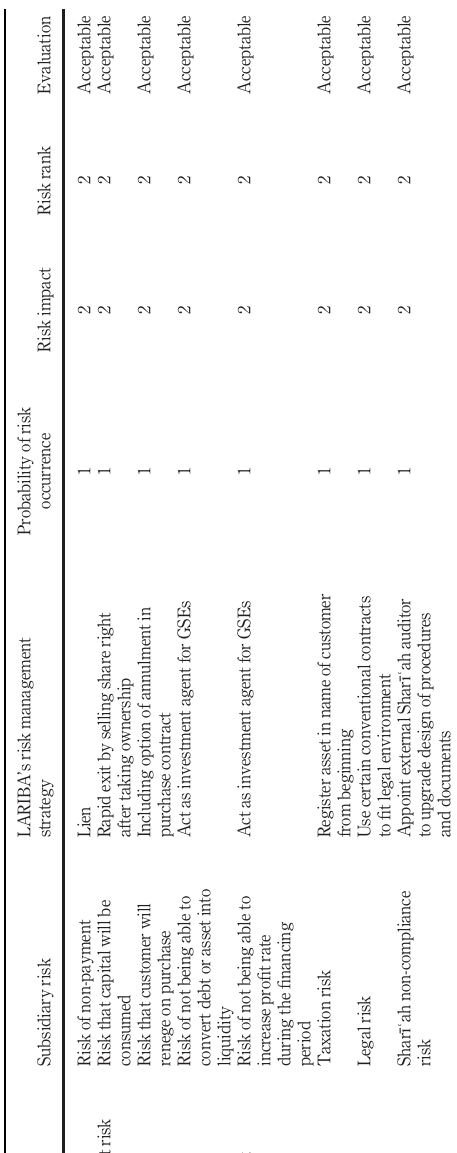
Table III. Quantitative analysis of the risks of financing by